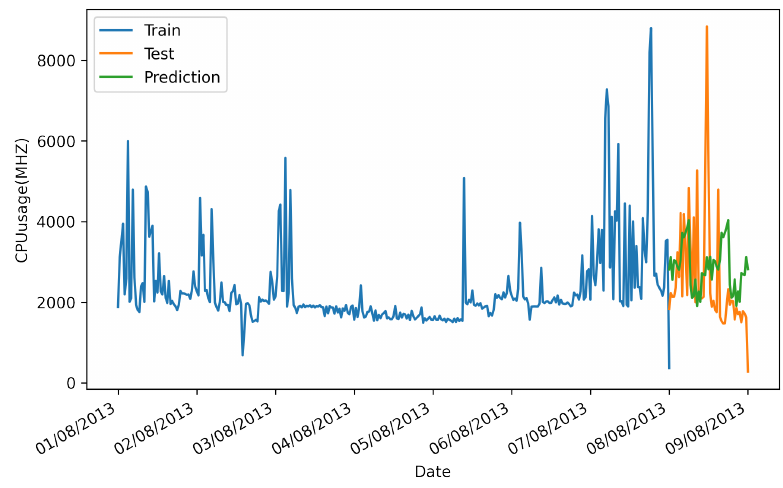
Figure 15. Prediction of CPU usage by using Holt–Winters method.